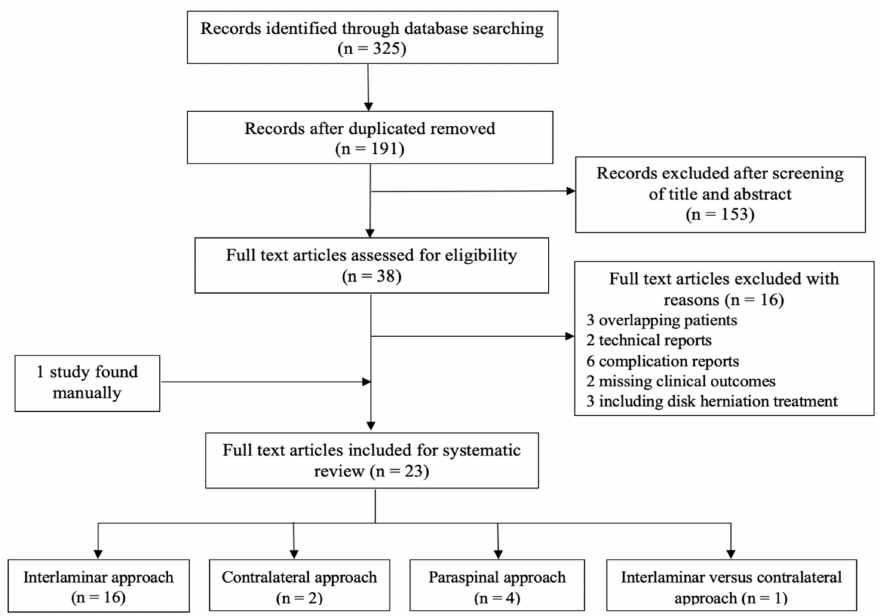
Figure 4. PRISMA flow chart for study